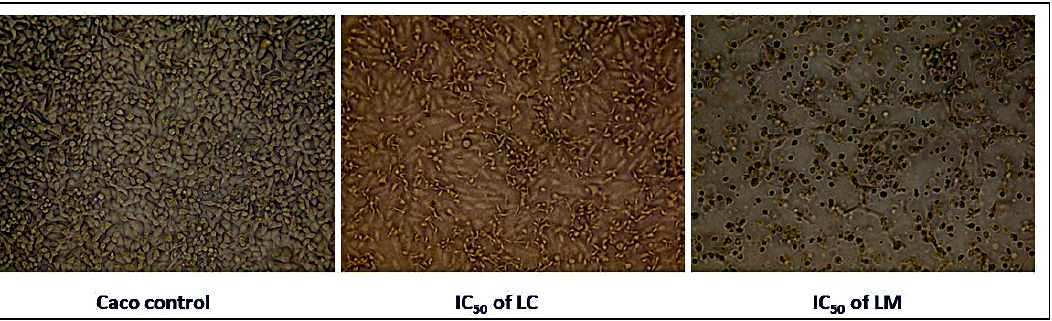
Figure 5. Morphological features of apoptosis in Caco cells treated with L. camara and L. monteviden- sis extracts (at their IC 50 concentrations) after 48 h.